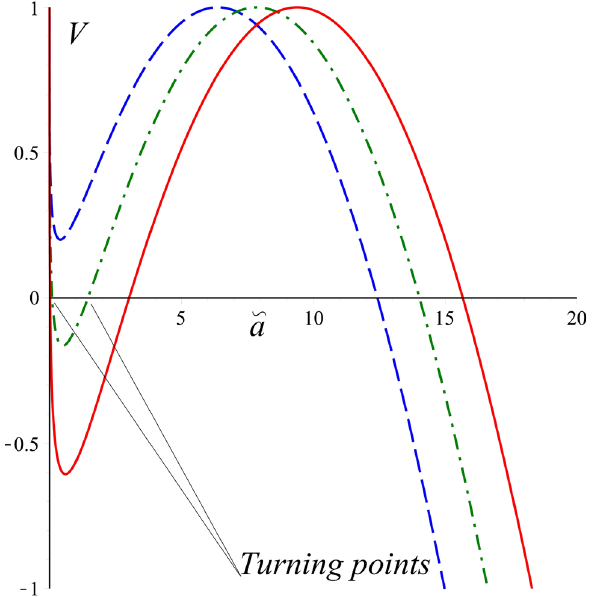
Fig. 1 Plot of V ( ˜ a ) versus ˜ a for ω = − 0 . 95 and ˜ η = − 0 . 55 , − 0 . 65 , and − 0 . 75 from top to bottom . The turning points for green ( dash-dot ) curve are also